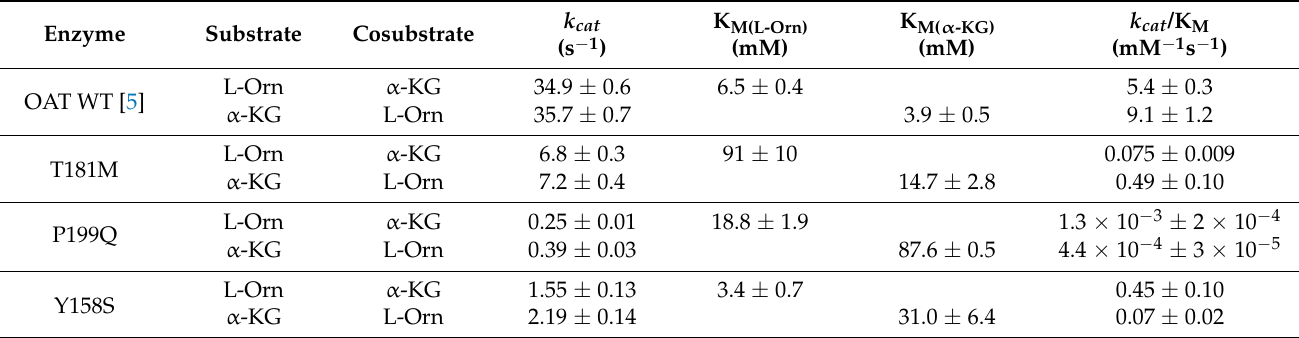
Table 2. Steady-state kinetic parameters of wild-type and variants OAT